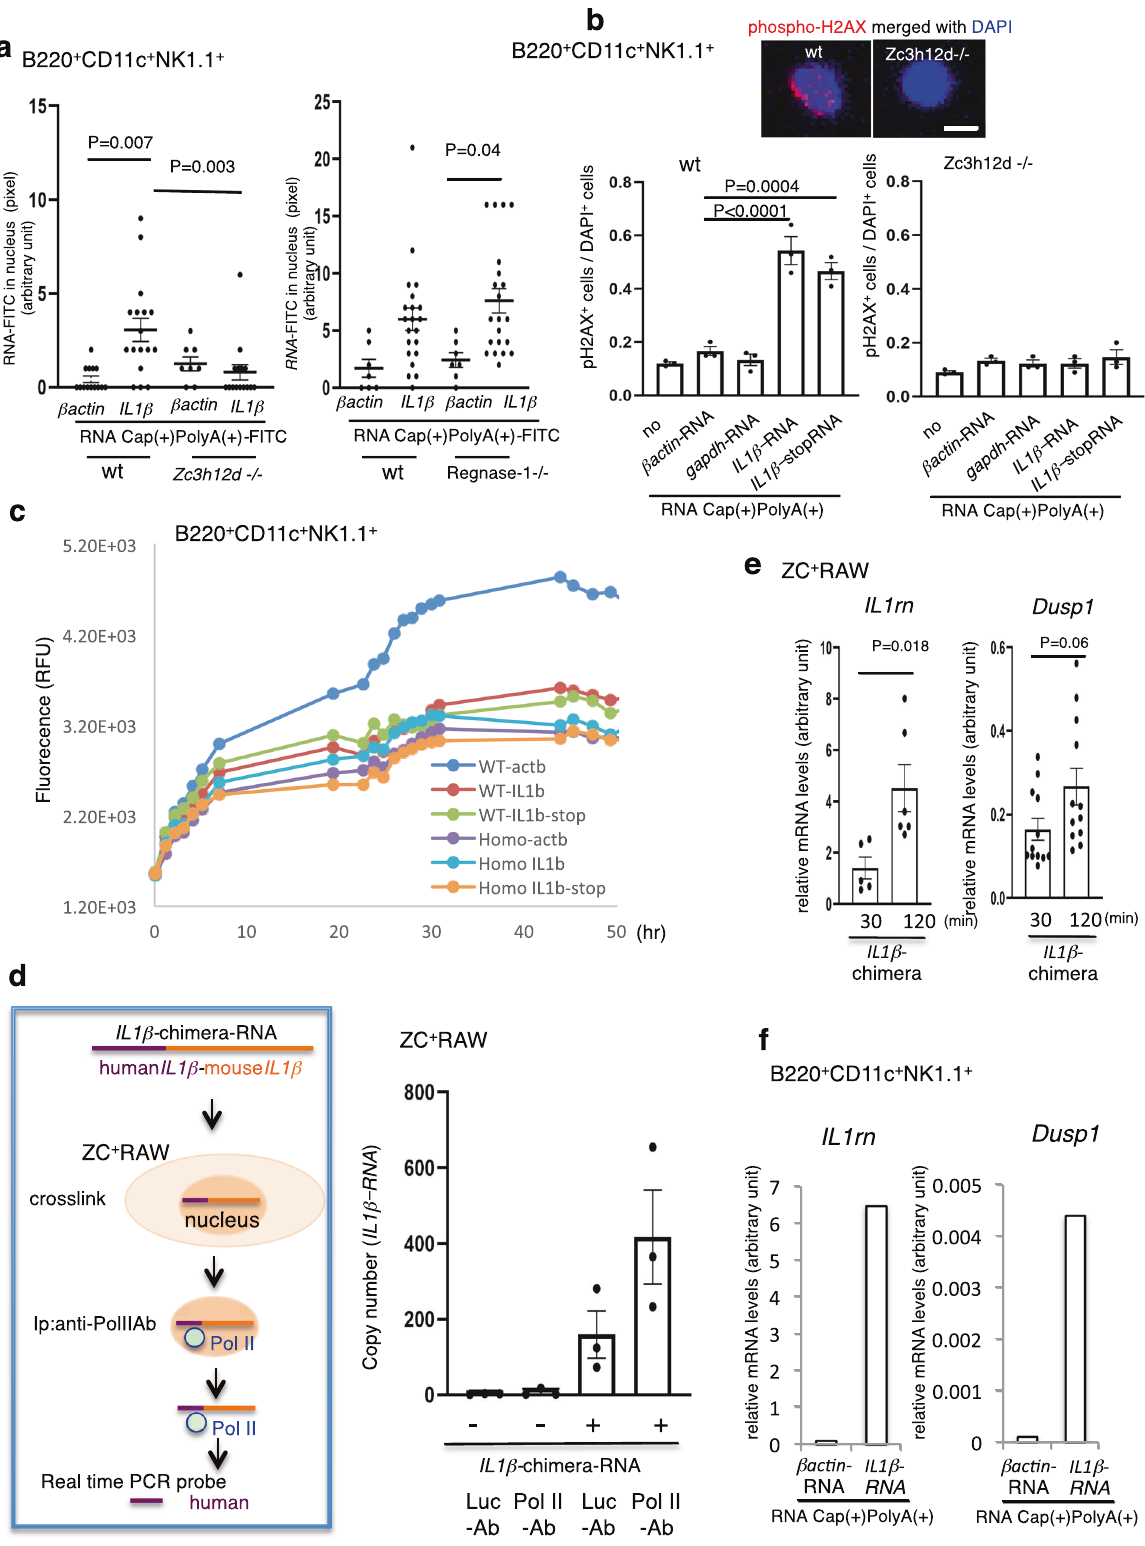
In fl ow cytometric analysis, ZC3H12D was detected on the cell surface of 46% of CD56 + CD3 - NK cells. FITC-labeled h IL1 β - mRNA, but not control h β actin -mRNA, was incorporated into the nucleus of CD56 + CD3 - NK cells (Fig. 7c). Small interfering RNA (siRNA)-mediated knockdown of ZC3H12D in CD56 + CD3 - NK